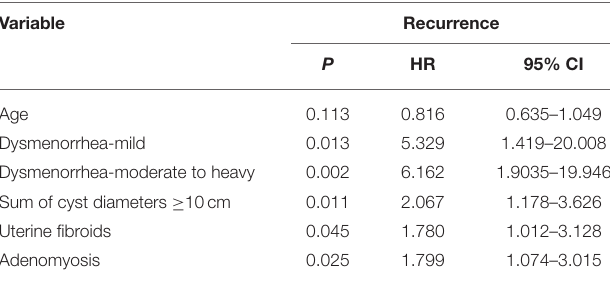
TABLE 2 | Multivariate analysis of the derivation cohort.